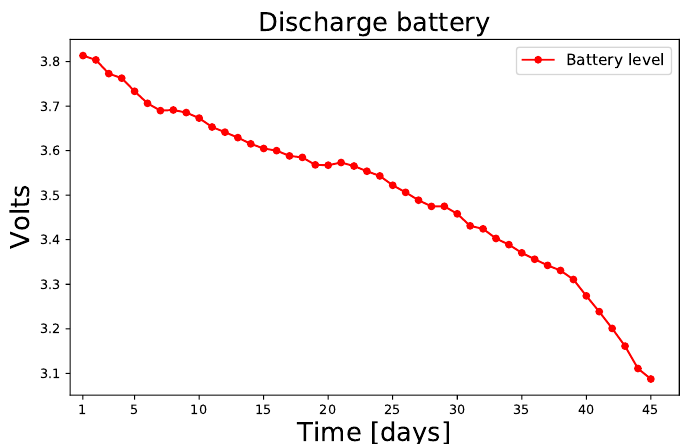
Figure 3. Discharging the SAFe module battery until the module cannot send